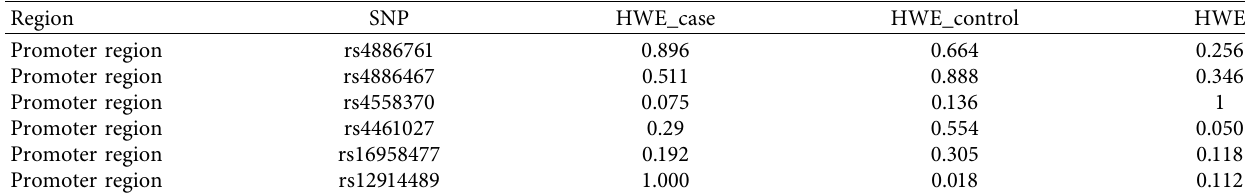
Table 2: The Hardy–Weinberg equilibrium test of these SNPs.